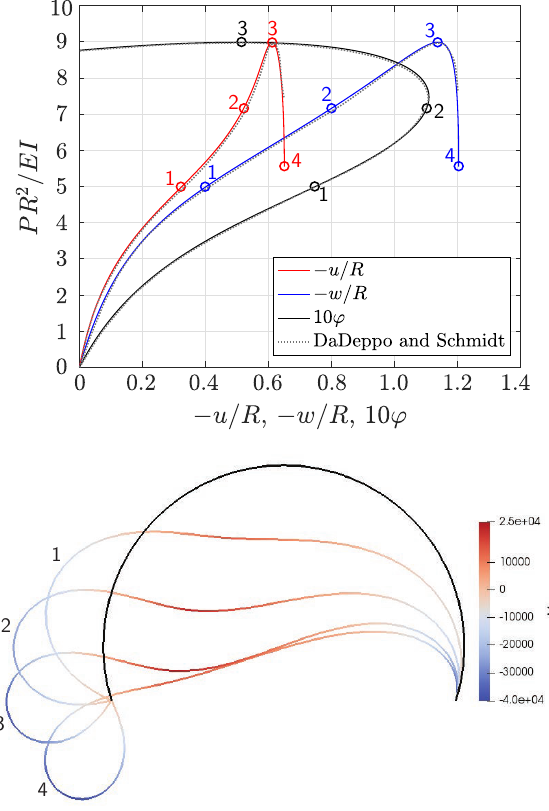
Figure 6. Load-displacements and load-rotation of the top of the arch (top). Grey-dashed line repre- sents the analytical solution reported by DaDeppo and Schmidt [10]. Deformed shapes and moment trend along the arch relative to the four load levels numbered in the top curves.